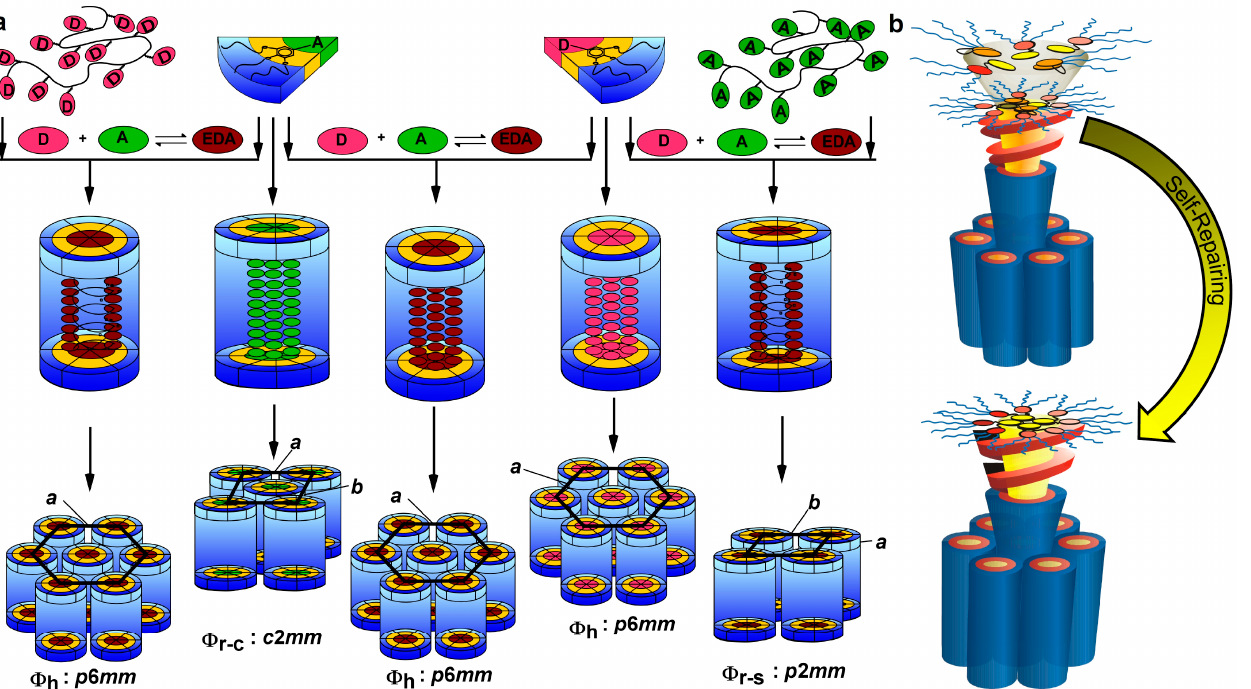
Figure 18. Schematic illustration of complex electronic supramolecular materials mediated by den- drons containing donor (D) and acceptor (A) groups, and their co-assembly with complementary amorphous polymers containing D and A side groups ( a ). The different systems form hexagonal columnar ( Φ h ), centred rectangular columnar ( Φ r-c ), and simple rectangular columnar ( Φ r-s ) arrays; a and b are lattice dimensions. The self-repairing process of back-folded (brown) electronically active supramolecular helical pyramidal columns self-assembled by semifluorinated minidendron attached to the acceptor groups ( b ) [200]. The Figure is adapted and modified from [201]. Copyright © 2002, Macmillan Magazines Ltd.